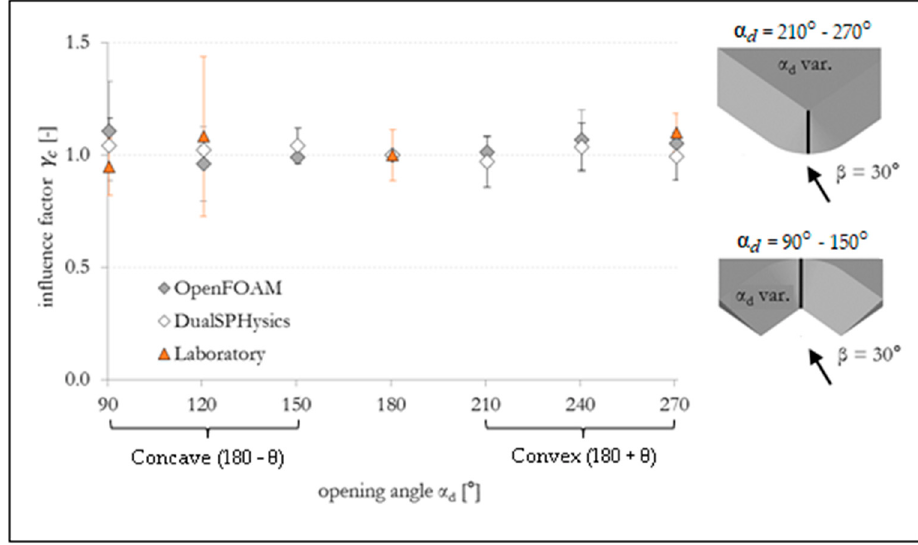
Figure 10. Influence of a curvature in the dike line on wave run-up for a 30° oblique wave attack– studied position: center of curvature.